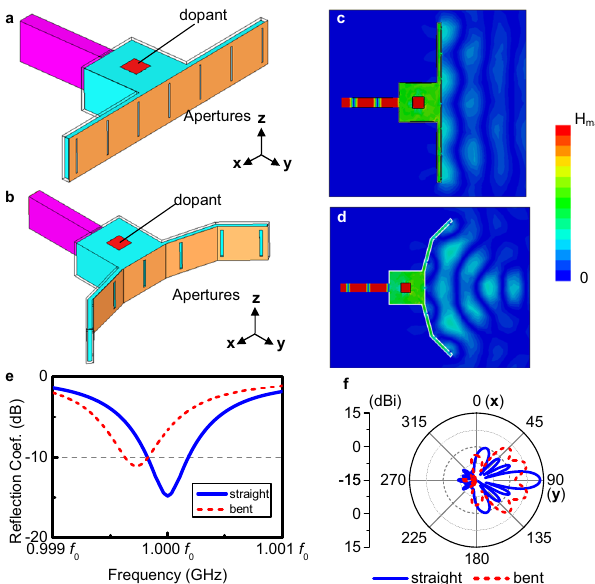
Fig. 5 Flexible-wavefront radiator switching from directional beam to near- fi eld focusing. a The 3D structure with a straight radiation aperture. b The 3D structure with a bent radiation aperture. c , d The time snapshots on the magnitude of magnetic fi elds at the central plane of these two antennas. e The simulation results for the re fl ection coef fi cients. f The angular distributions in the